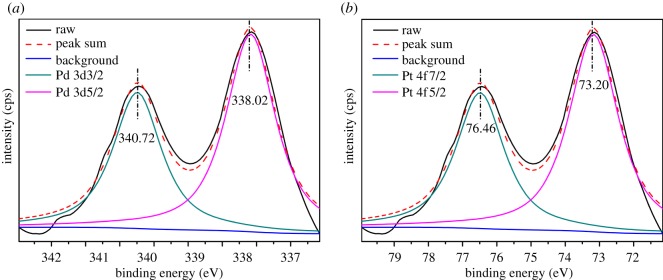
XPS spectra of the Pd 3d (a) and Pt 4f (b) regions for G4M-(Pt3/Pd7).